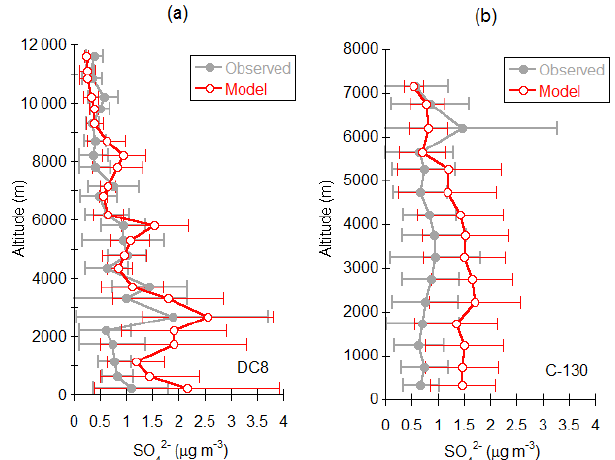
Figure 7. Comparison of modeled and observed campaign-average SO 2 − vertical profiles: (a) against measurements from the DC-8 4 aircraft and (b) against measurements from the C-130 aircraft. Also shown is ± 1SD for both observed and modeled